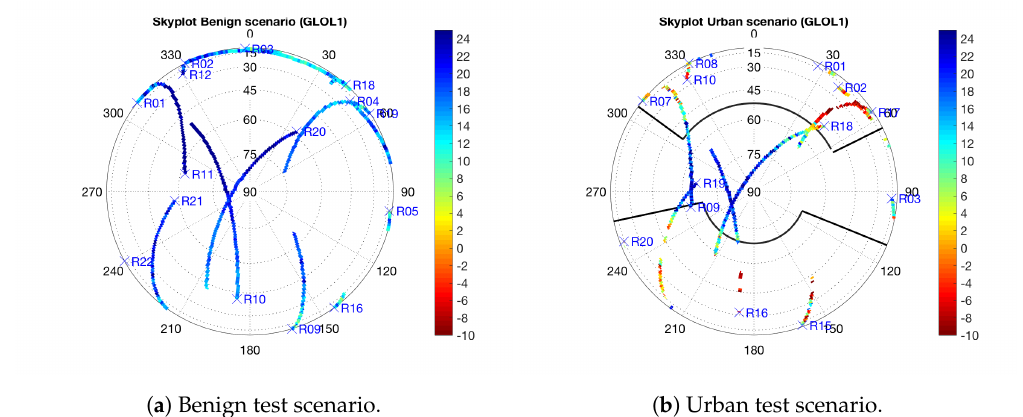
Figure 6. Ratio between RHCP and LHCP components in a sky plot. ( a ) Benign test scenario, and ( b ) Urban test scenario together with the elevation masks corresponding to the buildings in the scenario (see Figure 5a). Results for GPS L1 (up), GPS L2 (middle) and GLO L1